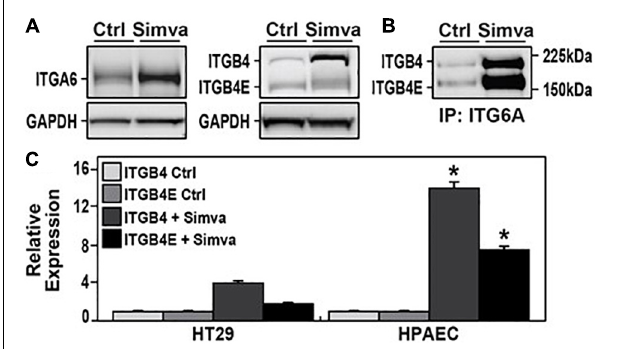
FIGURE 1 | Increased expression of integrin beta 4 (ITGB4) and integrin beta 4E (ITGB4E) in human lung endothelial cells (ECs) after simvastatin. (A) Human pulmonary artery ECs were treated with simvastatin (5 µ M, 24 h) and lysates were collected and subjected to Western blotting for ITGA6 and ITGB4. (B) In separate experiments, lysates from simvastatin-treated ECs were used for immunoprecipitation of ITGA6 followed by Western blotting for ITGB4. (C) Human colon adenocarcinoma cells (HT-29) and human pulmonary artery ECs were treated with simvastatin (5 mM, 24 h) and lysates were subjected to Western blotting for ITGB4. Relative densitometry is shown ( n = 3 independent experiments, * p < 0.05 compared with both untreated ECs and simvastatin-treated HT-29 cells).